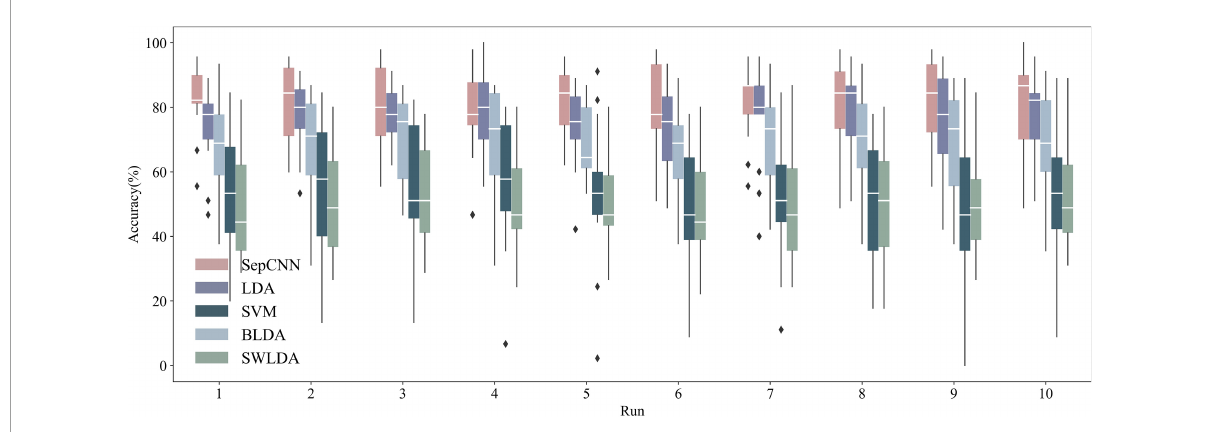
FIGURE7 Recognition accuracies of AR–P300 for all participants with different algorithms. The boxes from top to bottom represent the upper quartile (Q1), median (Q2), and lower quartile (Q3), respectively. The values for the upper and lower whiskers are Q1 + 1.5 × (Q1–Q3) and Q3–1.5 × (Q1–Q3),